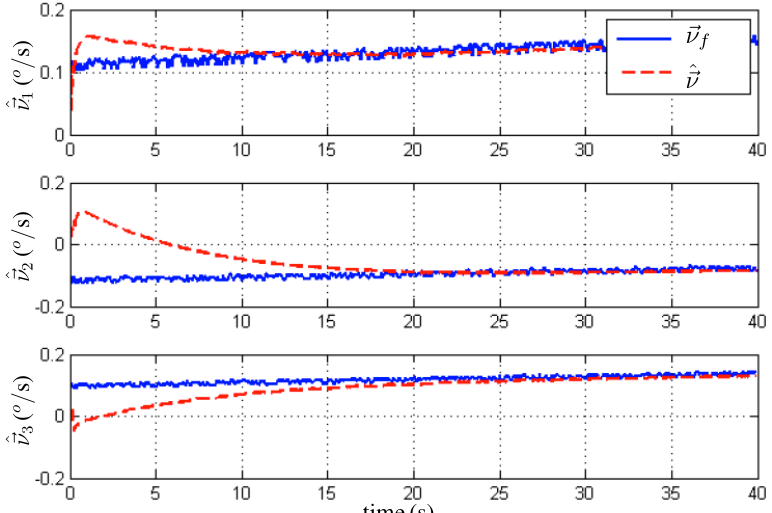
Figure 9. Evolution of the rate gyro bias estimate.